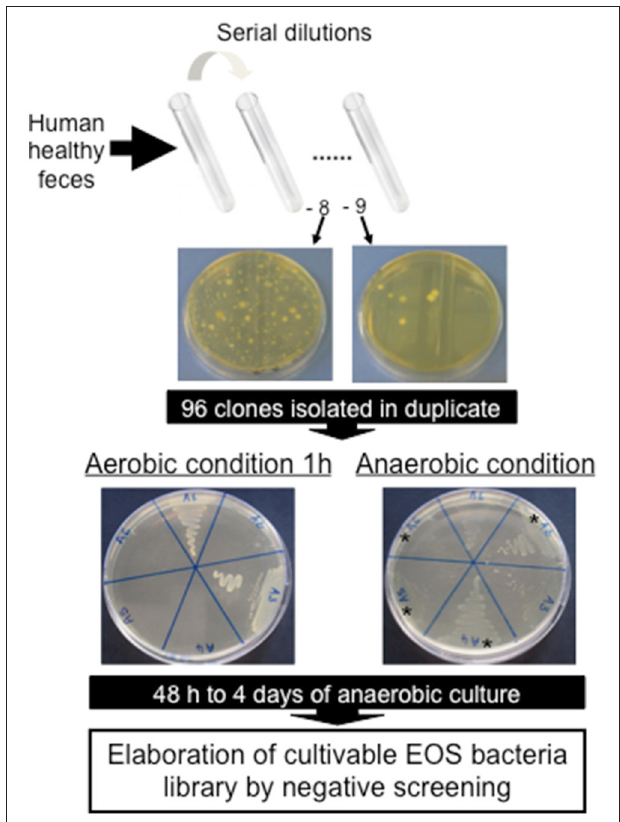
FIGURE 1 | Negative screening for isolation of new Extremely Oxygen Sensitive (EOS) strains from human healthy feces.